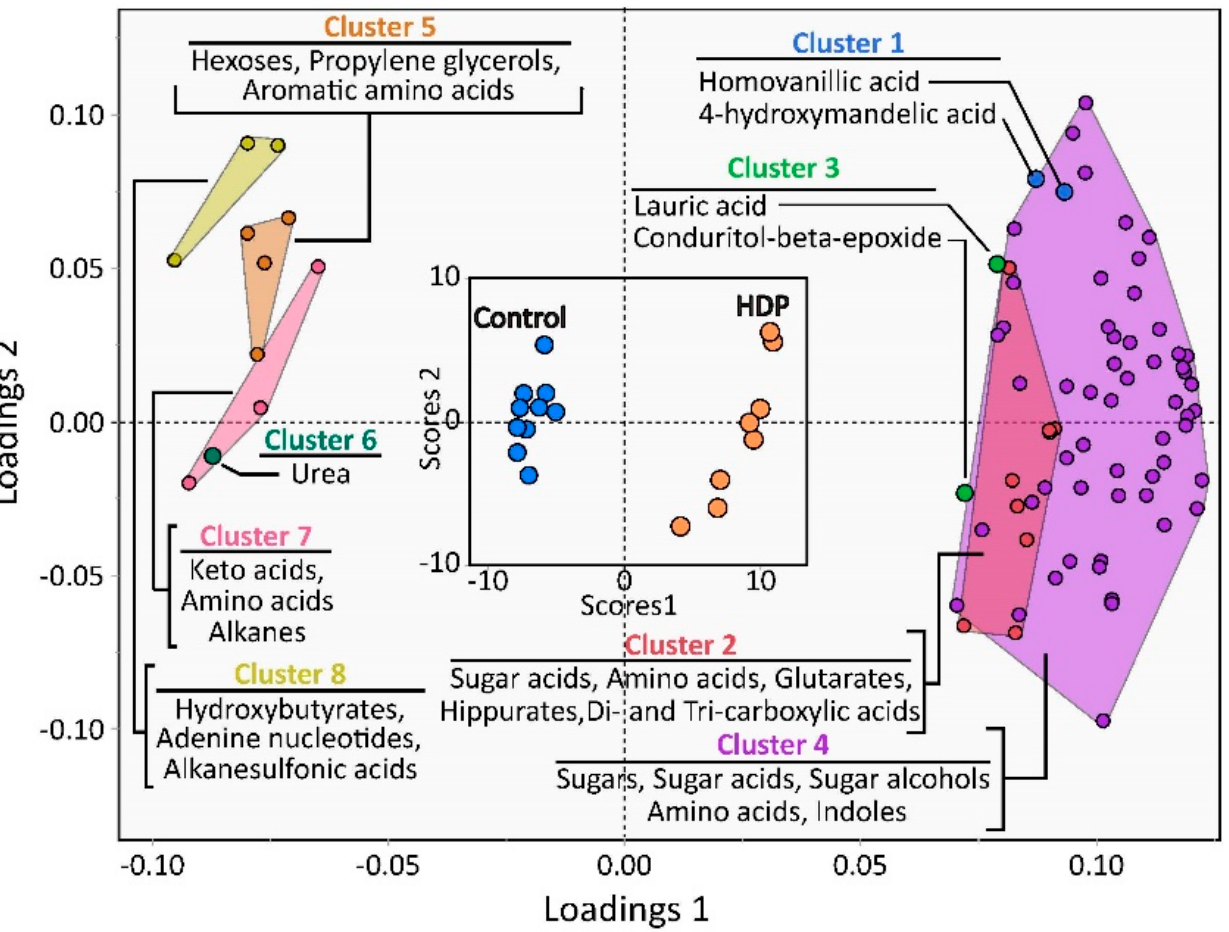
Figure 3. Partial least squares-discriminant analysis of untargeted metabolomic data. All detected metabolomic features were used for the discriminant analysis, but only